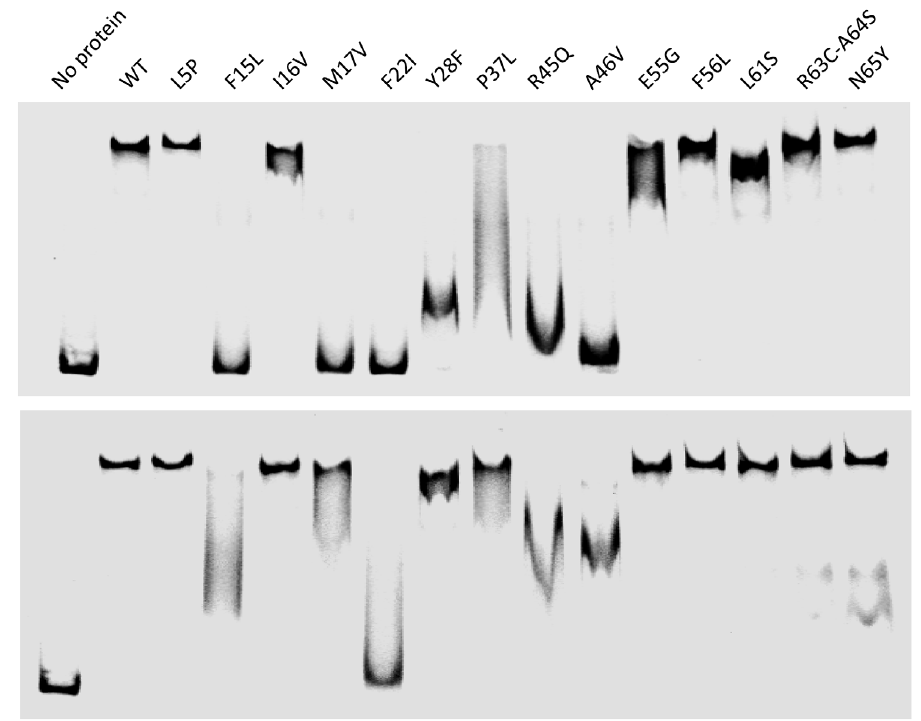
Figure 3. DNA binding activity of the TorI mutants. Electrophoretic mobility shift assay (EMSA) experiments were performed using the KplE1 attL recombination region that contains five cooperative binding sites for TorI [30]. Proteins were all used at a concentration of 10 µM whereas DNA concentration was either 20 nM (top) or 10 nM (bottom). When two torI alleles were available, only one was chosen for in vitro characterization, namely TorI-Y28F, TorI-R45Q, and